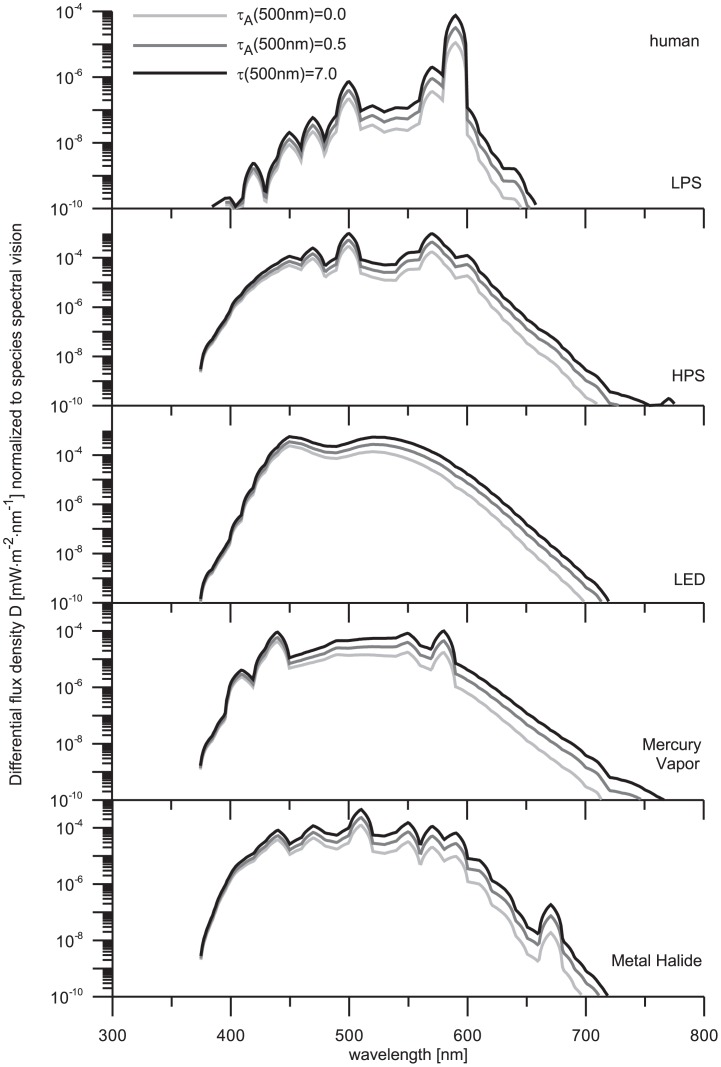
The legend to this figure is the same as in
Fig. 8
.